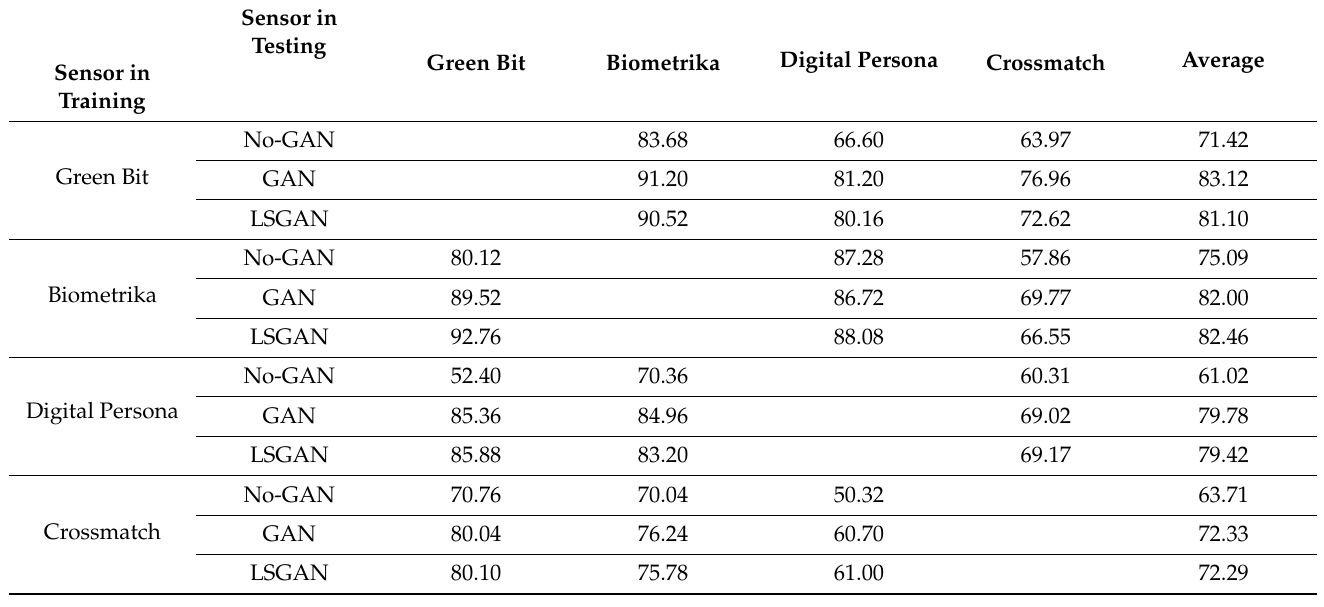
Table 6. Comparison between the results of the proposed network without using GAN, using GAN and using LSGAN on LivDet 2015 dataset in terms of classification accuracy (acc